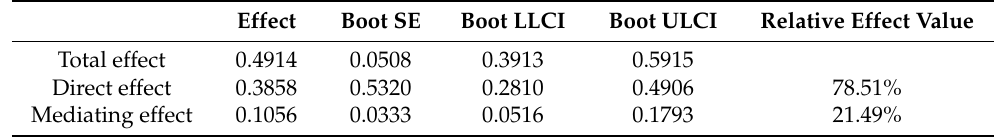
Table 6. Results of the bootstrap sampling